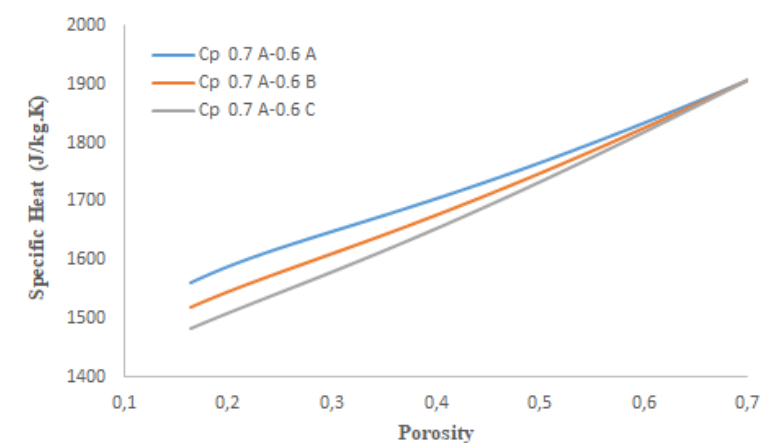
Figure 4. The effect of the thickness of the porosity of the material on the Specific heat Thermal conductivity for objects whose arrangement is considered parallel is influenced by the thickness of the material's porosity; as shown in Figure 5, the thicker the object, the greater the thermal conductivity. Still, the thicker the thermal conductivity will be at a certain thickness, and the line is not linear. The amount of temperature on the upper surface of a porous object is influenced by the object's thickness. As shown in Figure 6 shows, the thinner the object, the higher the temperature. The relationship between the object's thickness and the temperature is not linear, approaching a hyperbola. The object's thickness will affect the temperature changes on the object's surface, as shown in Figure 7; the thicker the object, the longer the time needed for temperature changes. The relationship between the object's thickness with temperature changes is not linear.